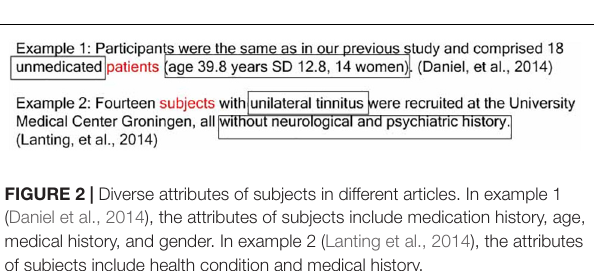
FIGURE 2 | Diverse attributes of subjects in different articles. In example 1 (Daniel et al., 2014), the attributes of subjects include medication history, age, medical history, and gender. In example 2 (Lanting et al., 2014), the attributes of subjects include health condition and medical